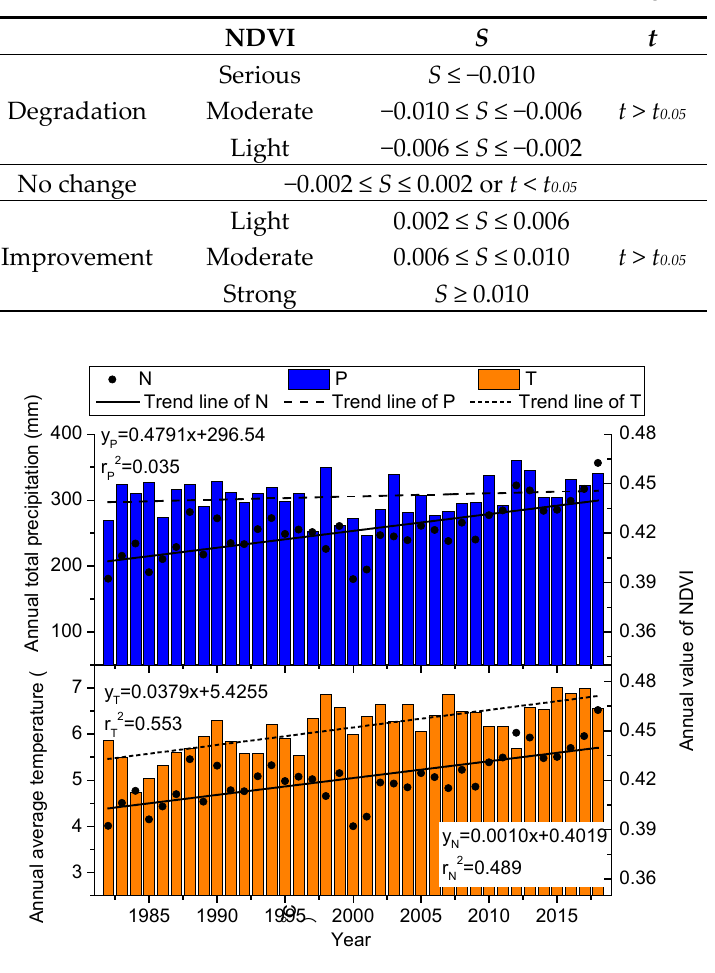
Figure 3. Variation in regional average annual NDVI (N), annual total precipitation (P), and annual average temperature (T) for northern China from 1982 to 2018.